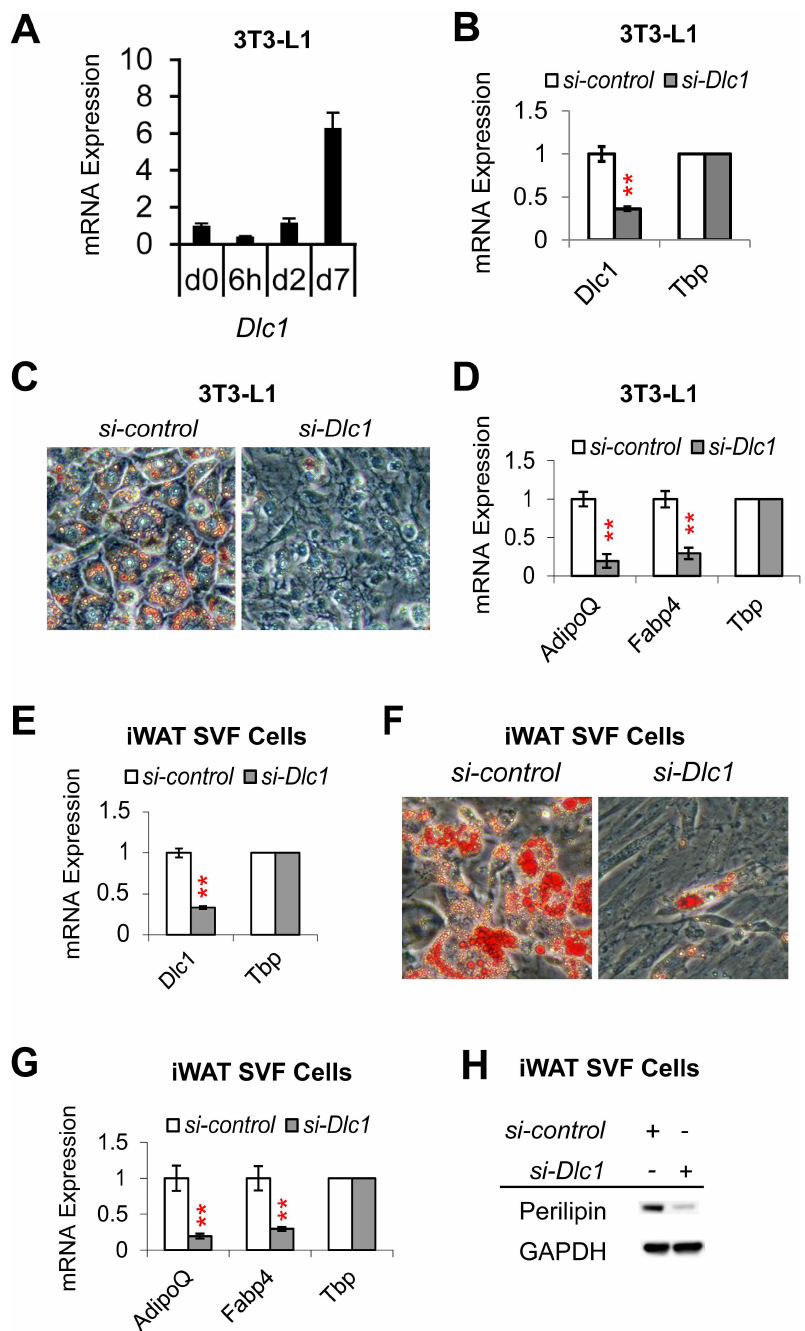
Fig 2. DLC1 is Required for White Adipogenic Differentiation. (A) mRNA expressionof Dlc1 gene during differentiation of 3T3-L1 white adipocytes. (B) qRT-PCR result showingthe knockdown of Dlc1 gene expressionin 3T3-L1 white adipocytes. Tbp was used as normalizingcontrol for gene expression. (C) Oil- Red-O stainingshowingreducedlipid droplet formation in Dlc1 knockdown cells. (D) mRNA expressionof adipogenicmarker genes Adiponectin ( AdipoQ )and Fabp4 in si-Dlc1 white adipocytes. (E) qRT-PCR result showingthe knockdown of Dlc1 geneexpressionin primary iWAT SVF cells derived white adipocytes. (F) Oil- Red-O stainingshowingreducedlipid droplet formation in primary iWAT SVF cell derived white adipocytes upon Dlc1 knockdown. (G) mRNA expressionof adipogenic marker genes Adiponectin and Fabp4 in si-Dlc1 white adipocytesderivedfrom primary iWAT SVF cells. (H) Western blotting analysisof mature adipocyte marker perilipinin primary iWAT SVF cell derived white adipocytesupon Dlc1 knockdown. Data are presented as mean ± s.e.m. n = 3–4 biologicalreplicates. Two-tailedStudent’s t -test was used: ** P < 0.01.